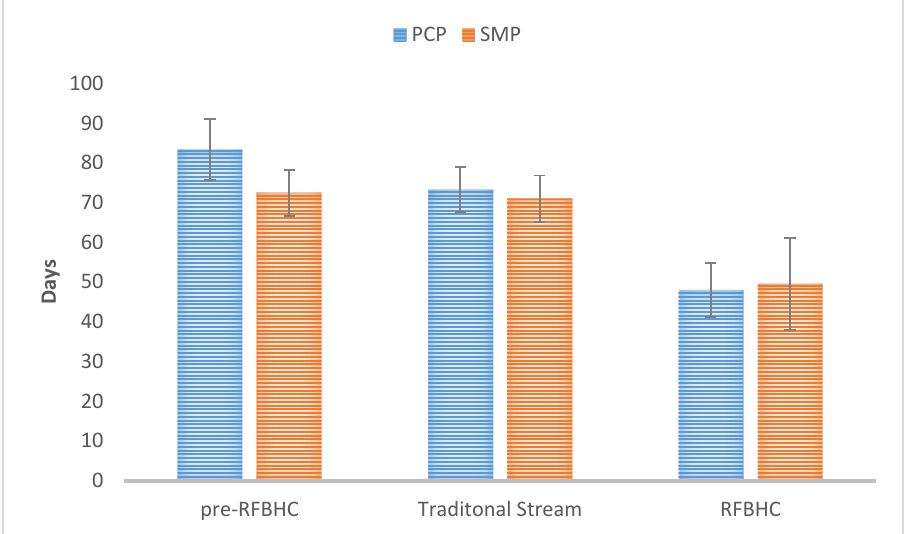
Figure 5. Overall wait time by referral source for each group. Whiskers represent 95% Confidence Figure 5. Overallwaittimebyreferralsourceforeachgroup. Intervals.